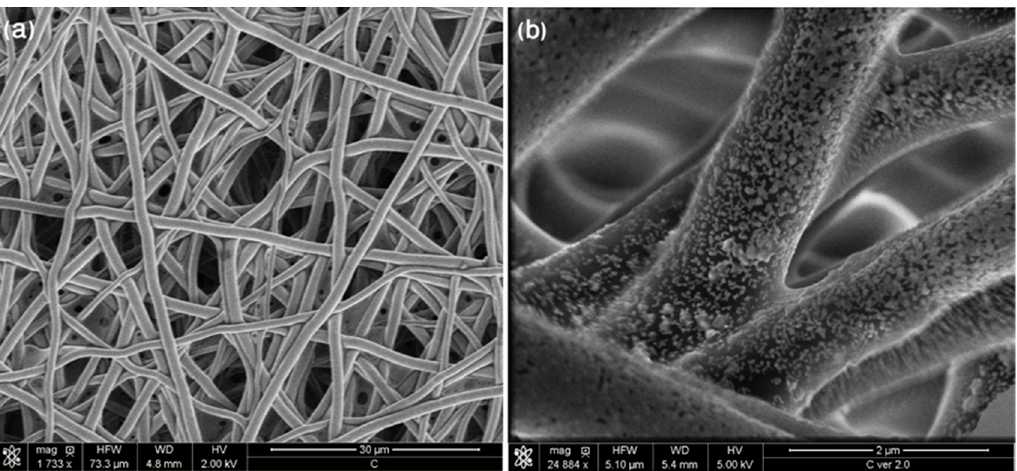
Figure 2. SEM images of electrospun polymer mat coated with gold layer (40 nm) at ( a ) lower and ( b ) higher magnification.